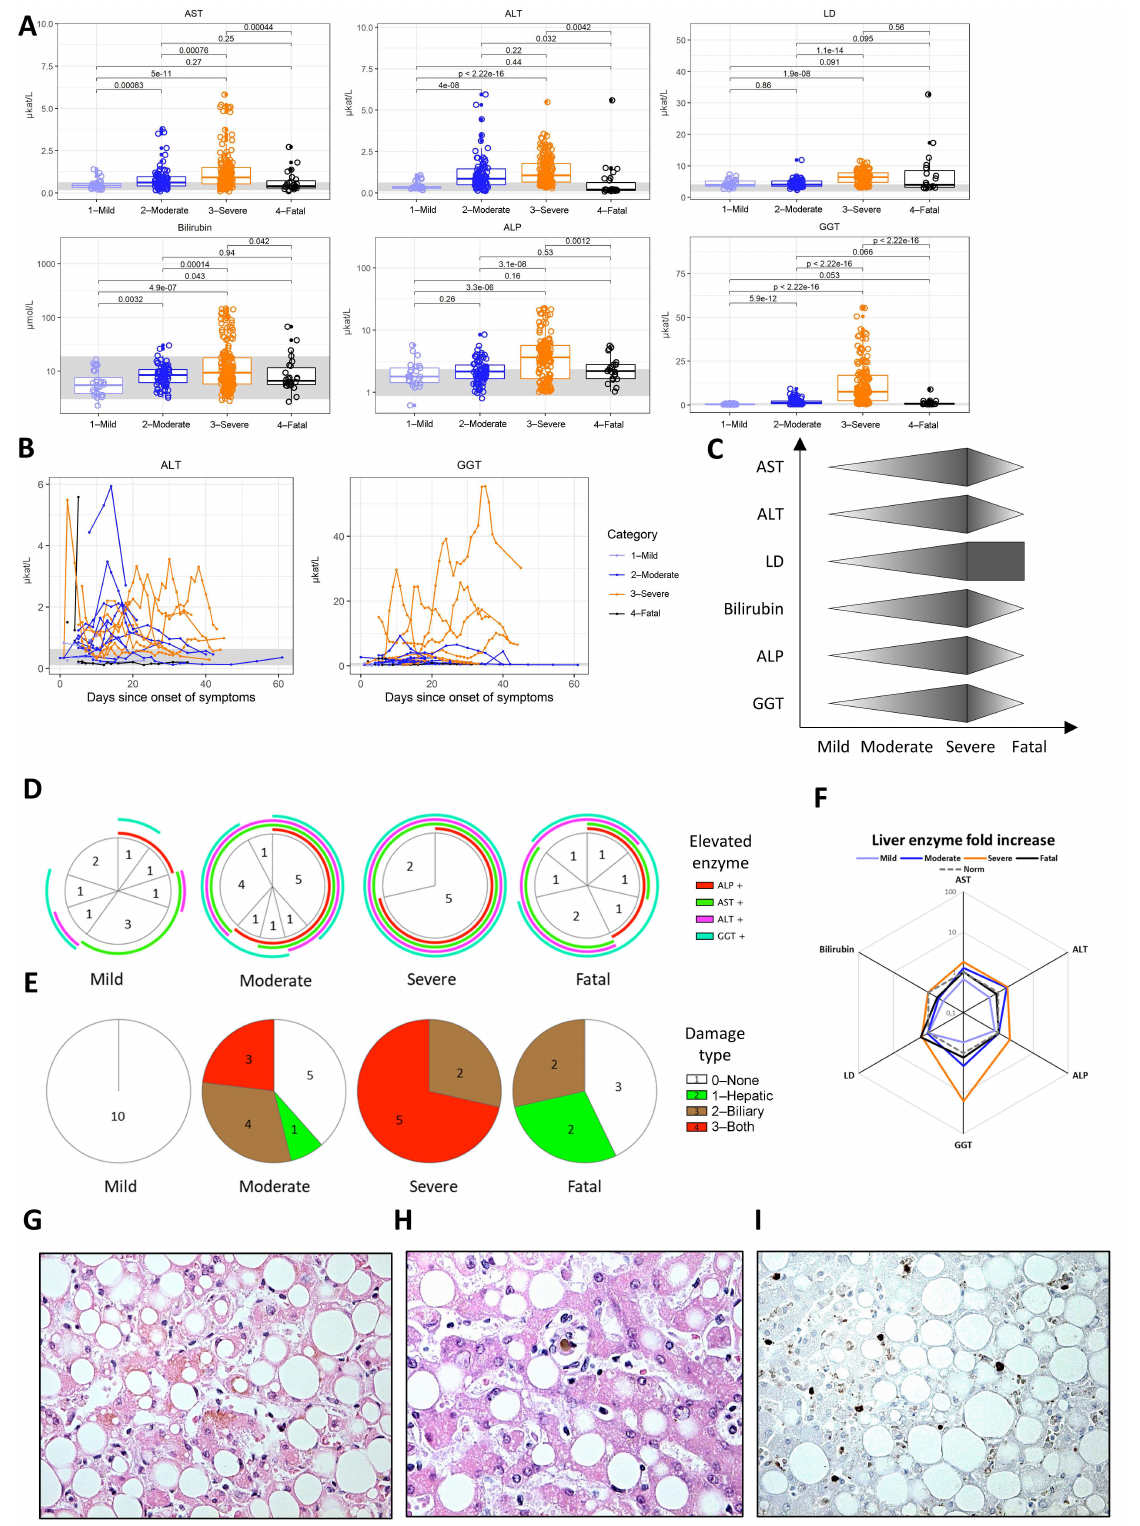
Figure 2. Hepatopathy. ( A ) Aspartate transaminase (AST), alanine transaminase (ALT), lactate dehydrogenase (LD), bilirubin, alkaline phosphatase (ALP), and gamma-glutamyl transferase